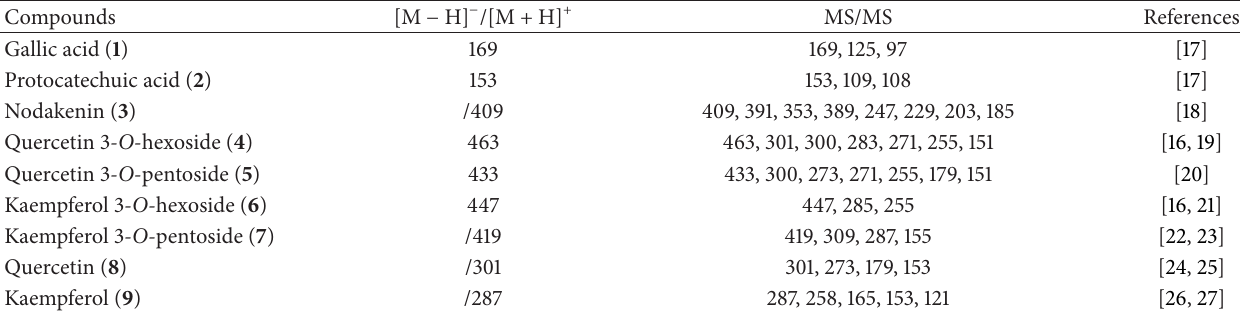
Table 1: Mass spectral data of the Euphorbia supina polyphenol mixture.